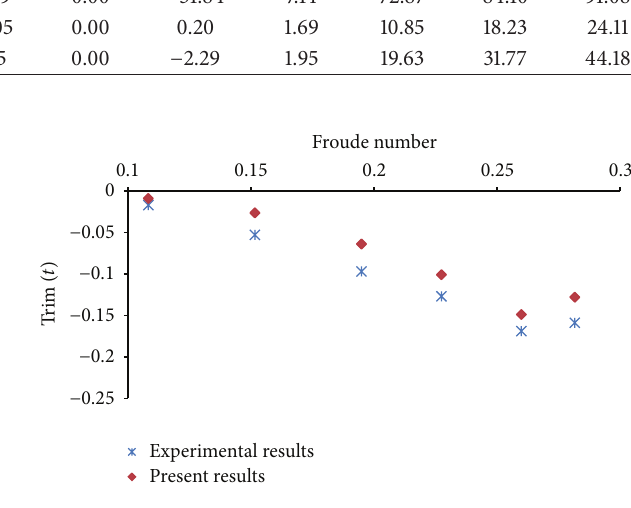
Figure 7: Comparison of simulation and experimental results of trim ( 𝑡 ).